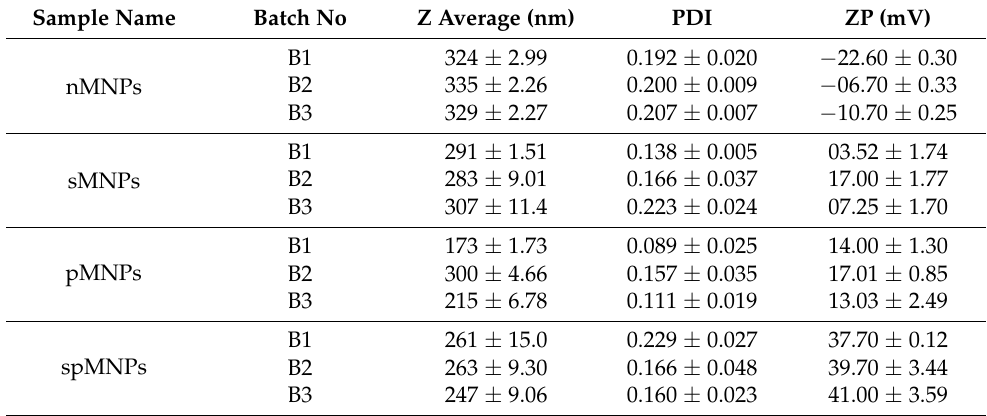
Table 2. DLS (the hydrodynamic diameter (Z average); the polydispersity index (PDI)) and the zeta potential (ZP) of the MNPs prepared by solvothermal